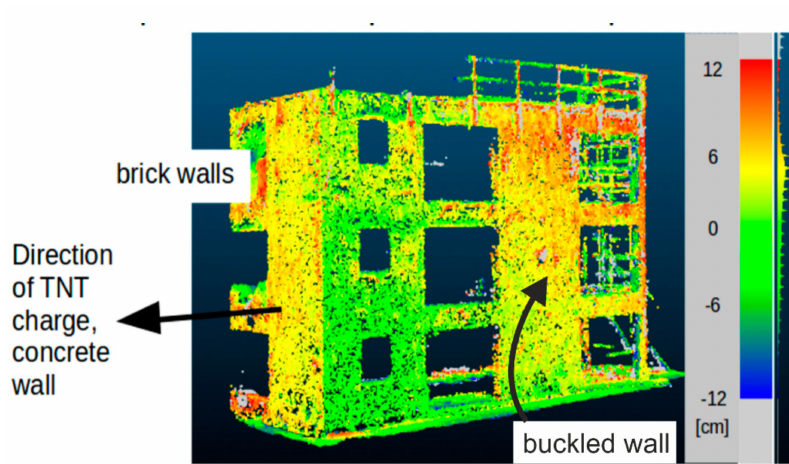
Figure 3. UAV-derived point clouds of reinforced concrete structure with brick in-fill walls subjected to exterior and interior detonations. Openings, cracks, and debris piles, as well as subtle deformation in the façades were automatically